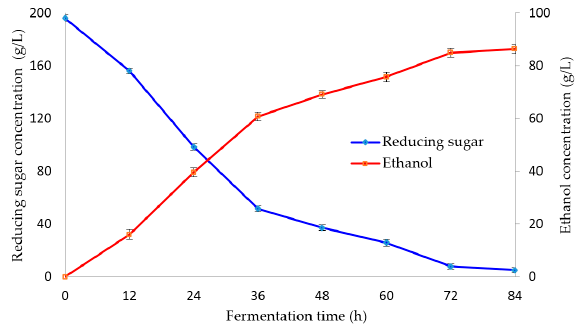
Figure 3. Ethanol and reducing sugar concentration versus fermentation time with Saccharomyces cerevisiae ( S. cerevisiae ). cerevisiae ( S. cerevisiae